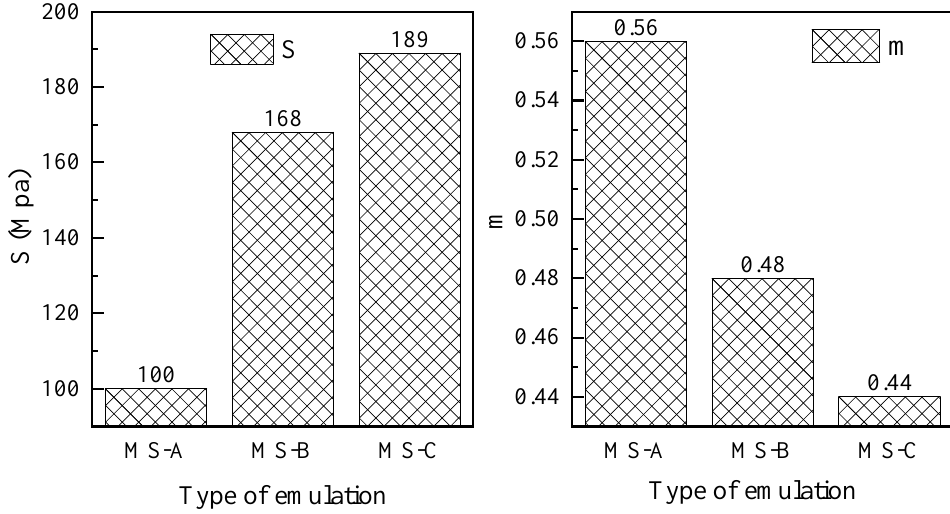
Figure 11. BBR properties from DSR frequency sweep test S(60) and